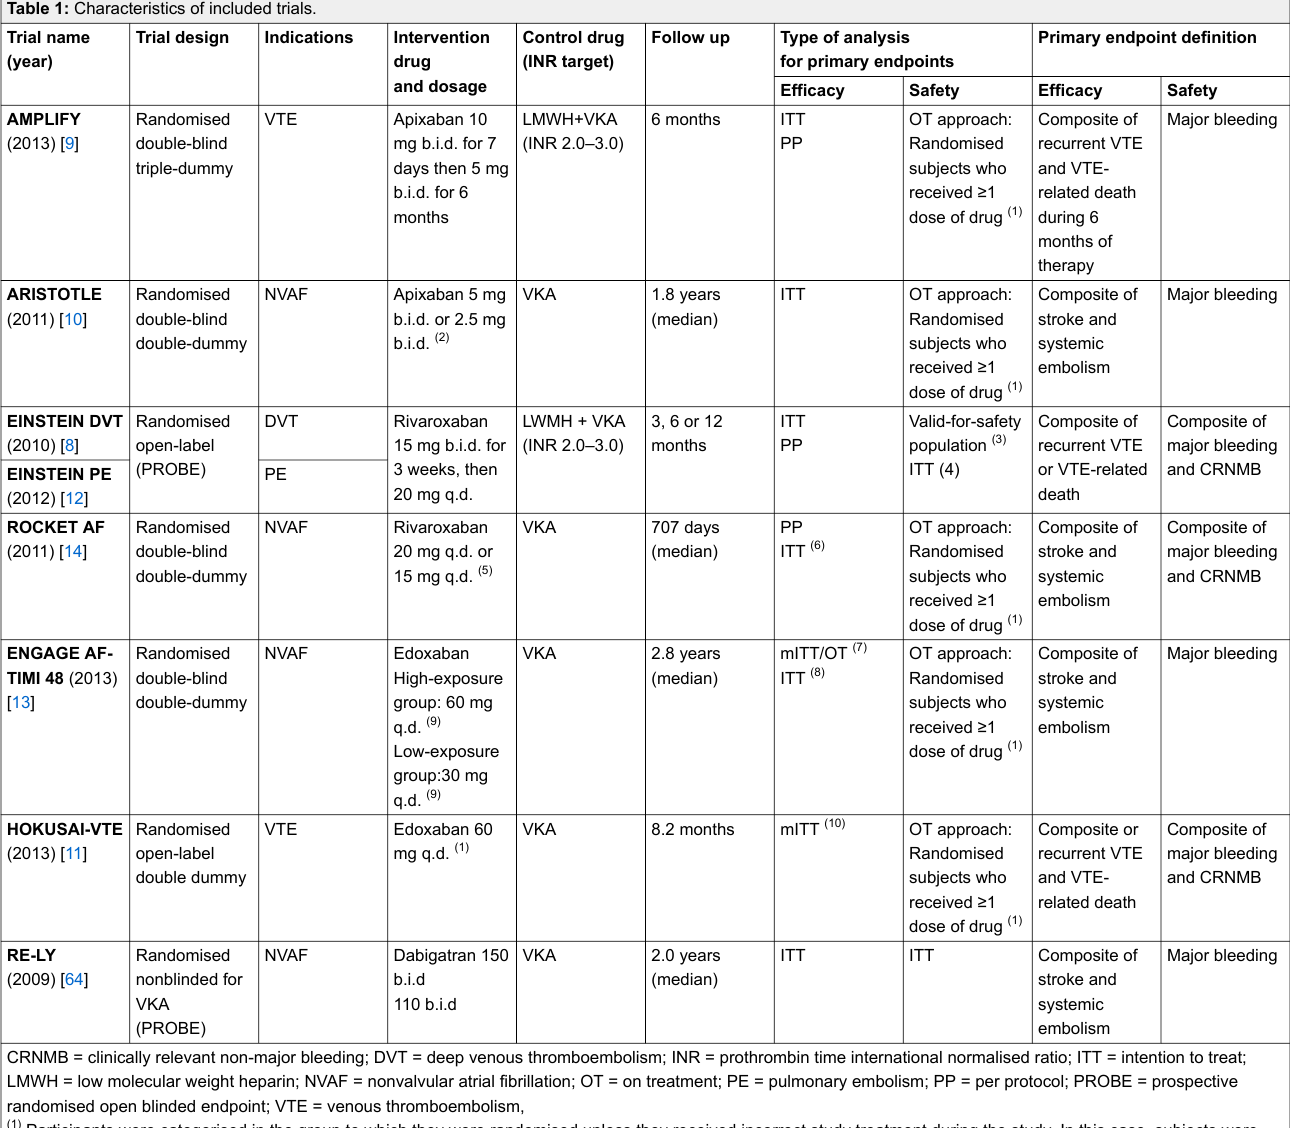
Table 1: Characteristics of included